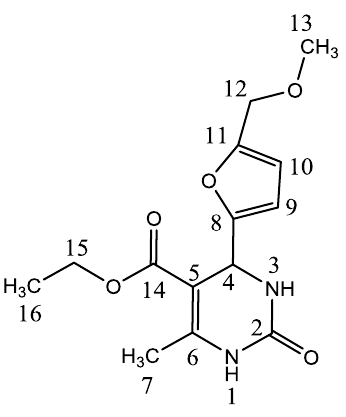
Figure 1. Numbering of the title compound.